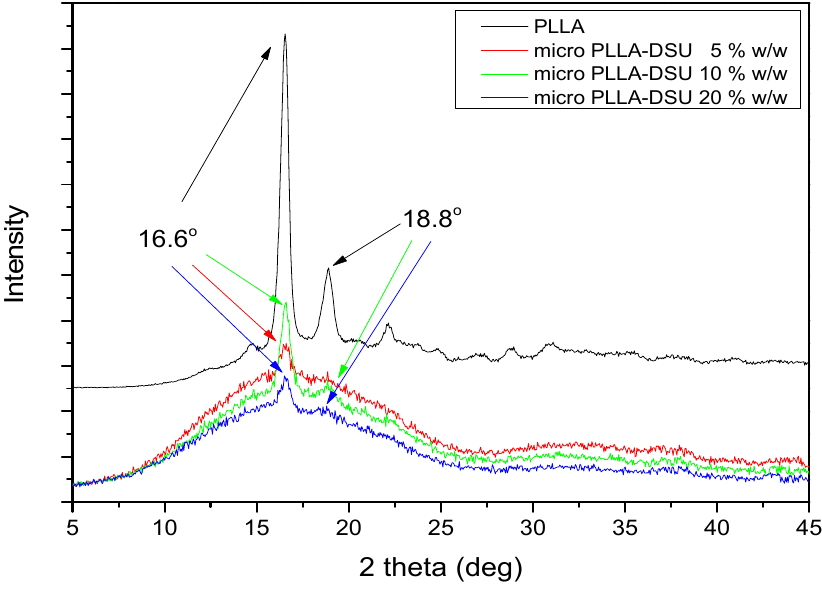
Figure 4. XRD patterns of PLLA and PLLA-DSU microparticles.